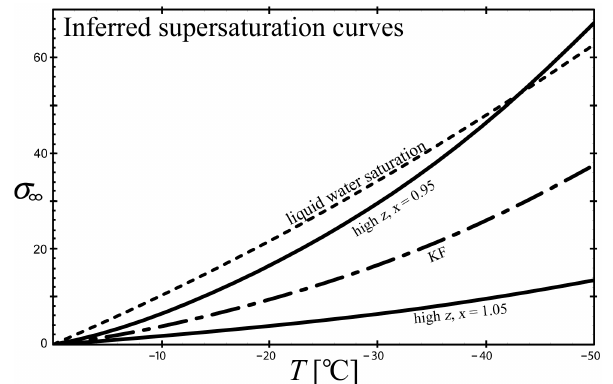
Fig. 4. Inferred supersaturation dependence to fit surface measure- ments of δ 18 O (Eq. 15). The three lower curves, when used in the integration of Eq. (16) with the α functions of Fig. 2 of the same la- bel, result in δ 18 O values equal to those in Eq. (15). The top curve is the supersaturation of a cloud of water